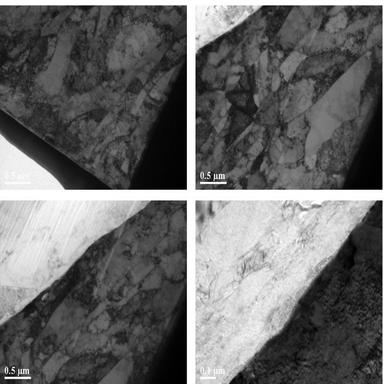
TEM images showing the grain structural evolutions inside the Mg- and Ni-sides after AFF consolidation of the layered composite structure.